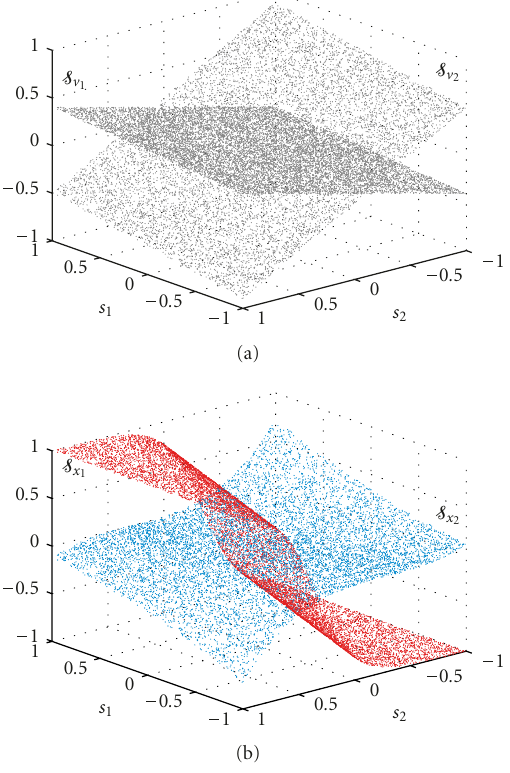
Figure 3: Example of a PNL mixing system in 3D space. (a) Planes S S v 1 and v 2 correspond to linear mixtures v 1 and v 2 . (b) Nonlinear and S x correspond to PNL mixtures x 1 and x 2 . surfaces S x 1 2